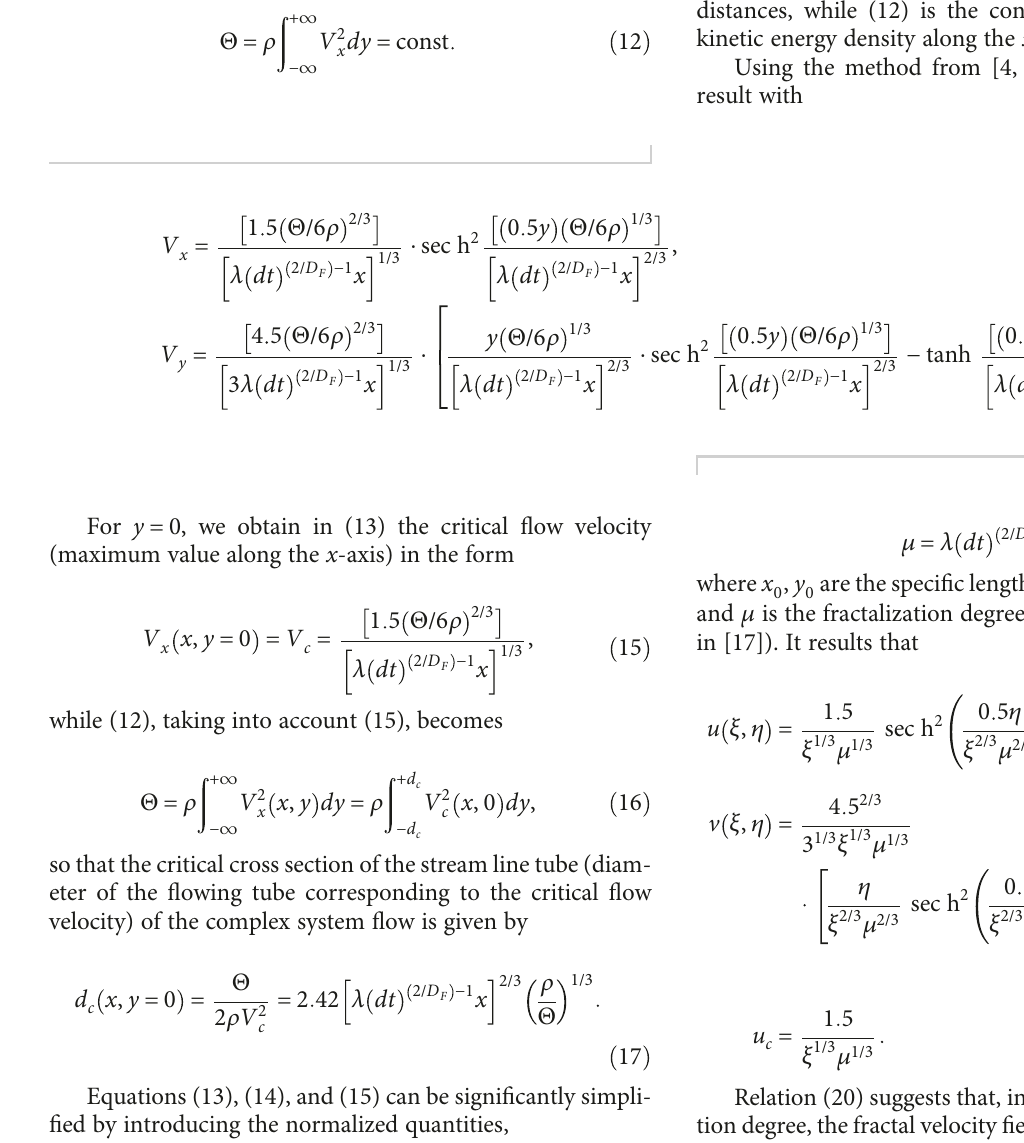
(Figure 1(c)), for the fractalization degree μ = 1 . It results with a central symmetry axis of the fl ow O ξ and a decrease of the velocity norm from the left boundary. Meanwhile, the local central maximum is adjacent with two symmetrical regions of the